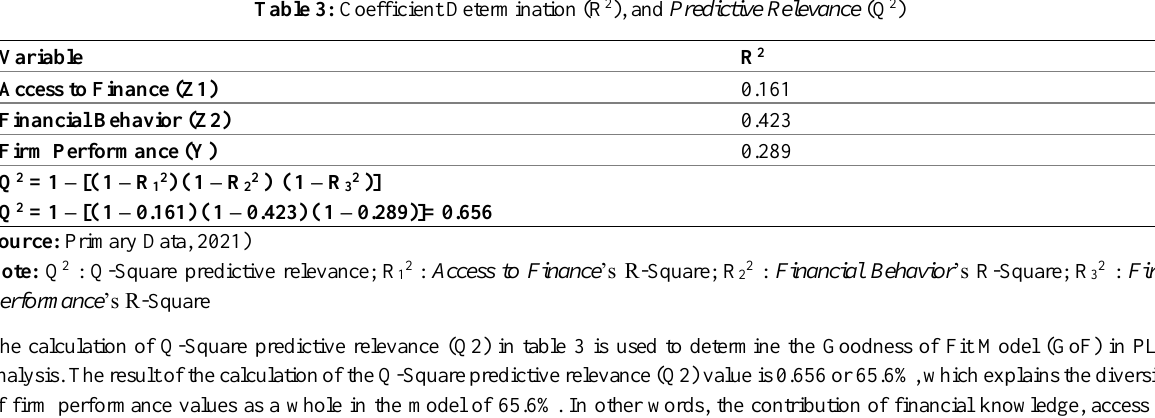
Table 3: Coefficient Determination (R 2 ), and Predictive Relevance (Q 2 )